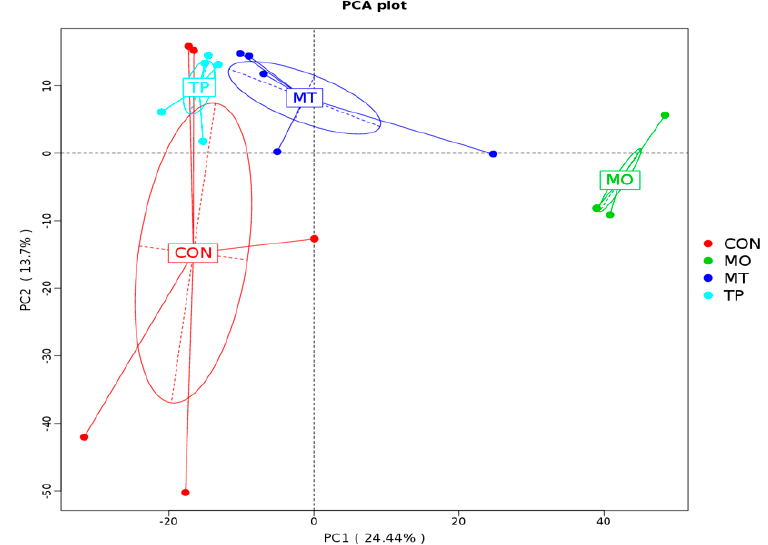
Figure 3. Principal coordinate analysis plot of the cecum microbiota based on the unweighted UniFrac metric.